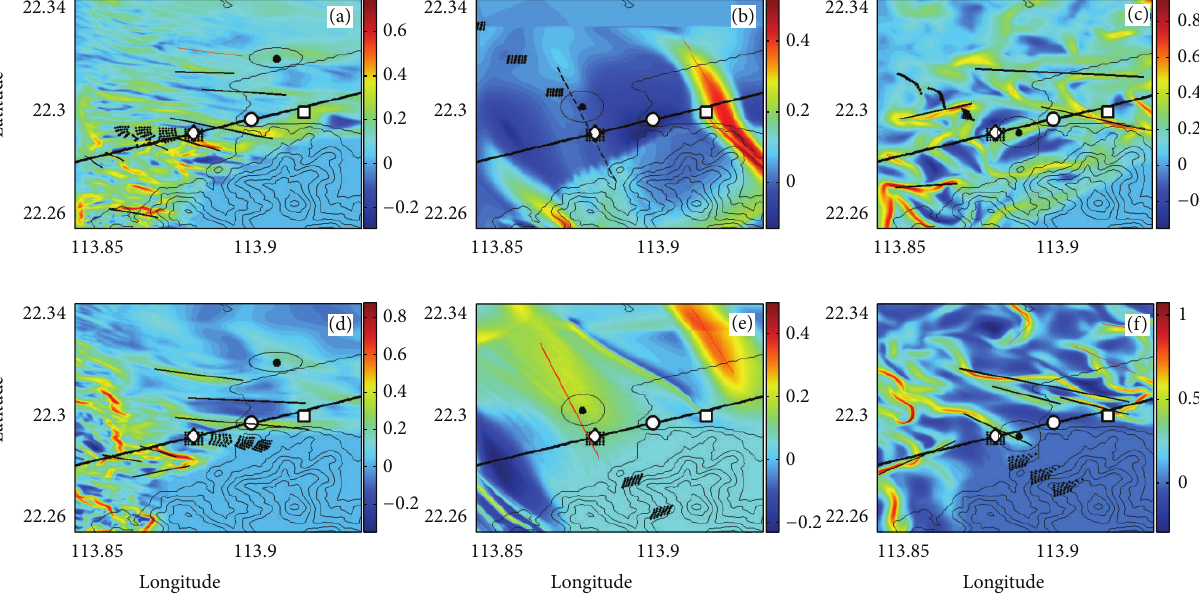
show much correspondence at this location. For WRF data, to the east of the − 1 NM location, the 3D analyses show a structure transversal to the landing trajectory yet 2D analyses show a structure aligned with the landing trajectory. We focus on this region to see what trajectory behaviors lead to these results.